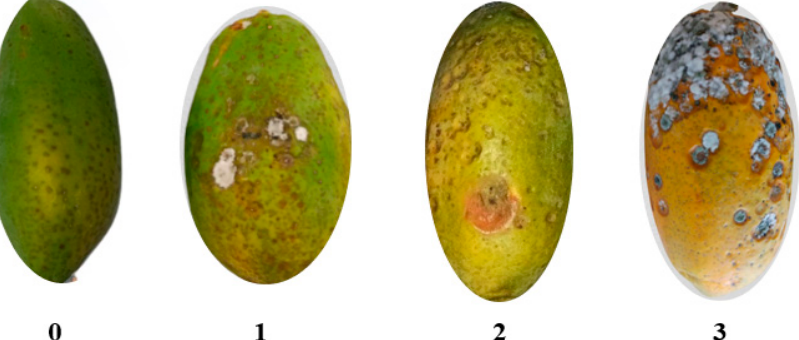
Figure 1. Representative fruits assigned to an empirical scale (0–3) of symptoms caused by fungal infection to quantify the incidence and severity of the disease on the papaya fruit: 0 = no visible symptoms (healthy fruit); 1 = 1–25% of the surface is covered with light mycelium (mild infection); 2 = 26–50% of the surface is covered with mycelium (moderate infection); 3 = 51–75% of the sample is necrotic with masses of spores appearing (strong